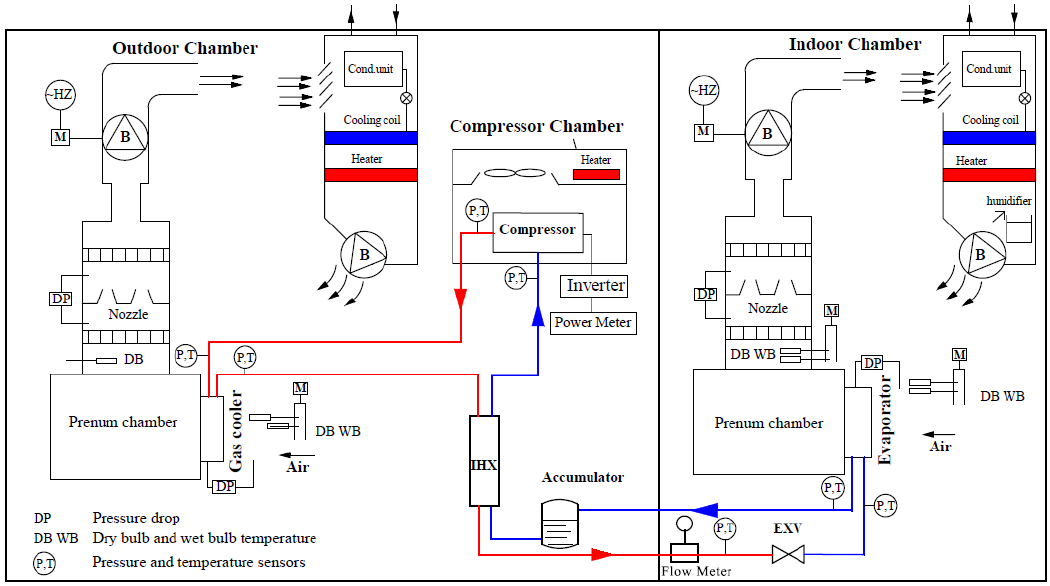
Figure 1. Schematic diagram of the calorimeter facility used to measure MAC system performance.